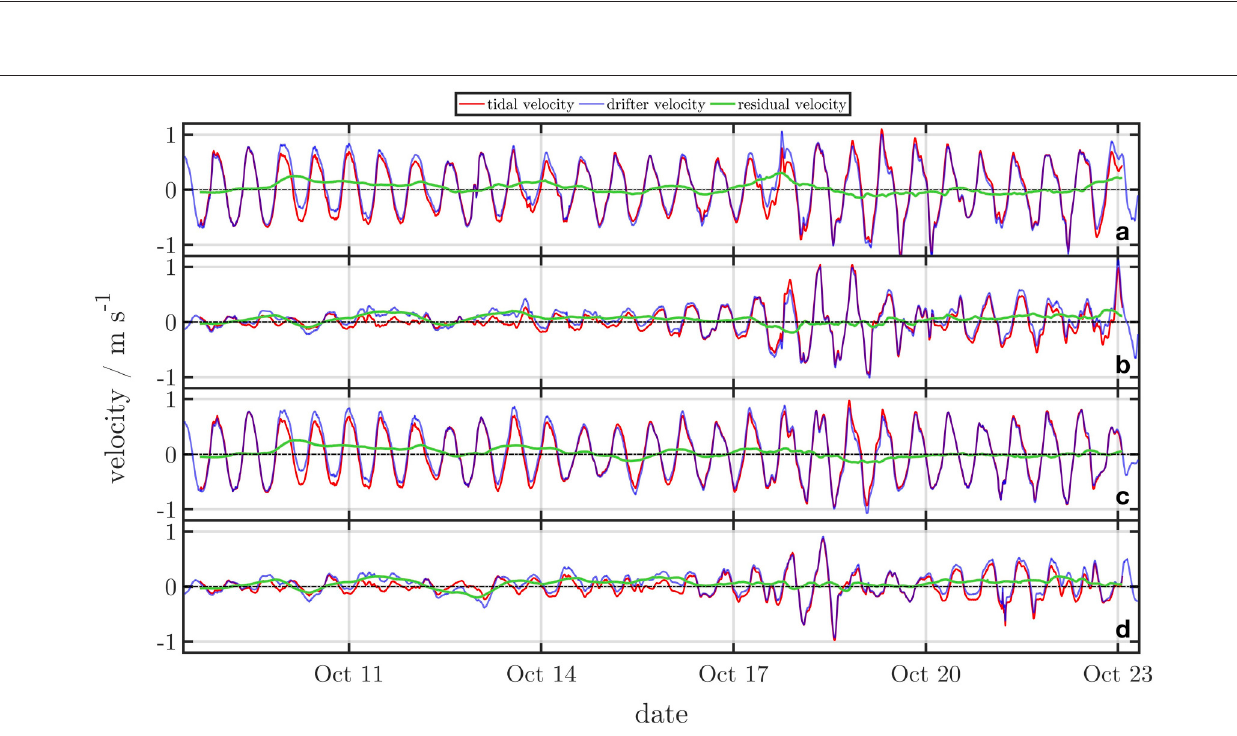
Frontiers in Marine Science |